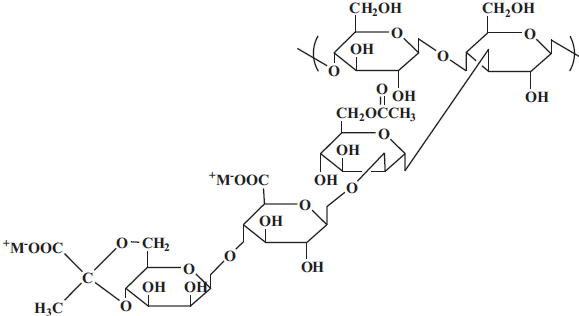
Figure 1: Xanthan gum chemical structure. Figure by